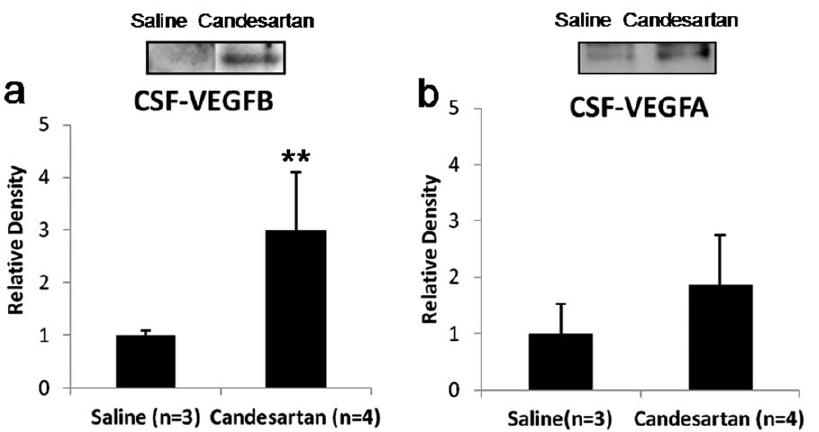
Figure 3. VEGF expression in CSF. Western blot was performed on the cerebrospinal fluid (CSF) from candesartan and saline treatment animals at 24 hours after stroke onset. Treatment with candesartan significantly increased VEGFB (Figure 3a, **P , 0.01) protein expression in the CSF. However, no significant difference was found for the VEGFA protein expression (Figure 3b).